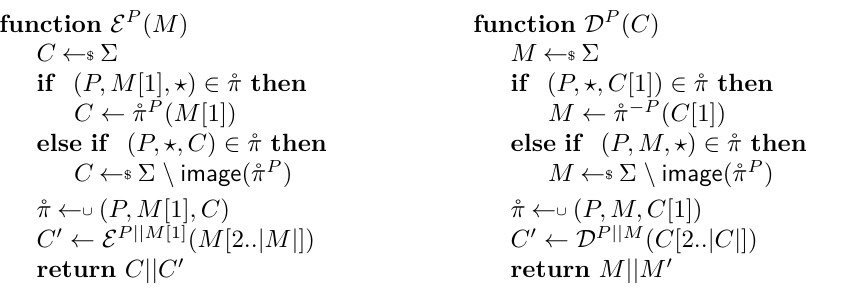
Figure 5: A mechanism for lazily sampling an ideal online permutation E with inverse D and internal table ˚ π after processing prefix P . The table ˚ π is initialised empty. We observe that if ( P, M, ? ) / ∈ ˚ π then ( P || M, ?, ? ) / ∈ ˚ π (because of how ˚ π is filled in). The